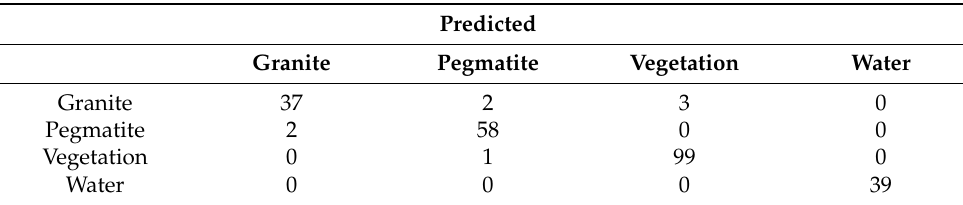
Table 5. C1 model confusion matrix.